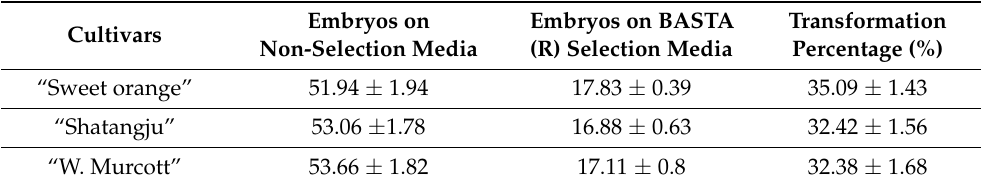
Figure 4. Embryonic callus induction, somatic embryo production, suspension cell culture estab- lishment and plant regeneration of the “Sweet orange” ( Citrus sinensis ) cultivar. ( Aa ) Embryonic callus induction from 8 weeks old ovule on EME medium ( Ab ) and somatic embryo development, ( B ) Suspension cell culture establishment in an H+H medium, ( C , D ) Callus formation and embryo ger- mination from suspension cell culture on an EME malt medium (the bars represent 0.5 mm), ( E ) Axis elongation of germinated embryos on an B+ medium, ( F ) Plants on RMAN rooting medium for root induction, ( G ) In vitro shoot grafted rootstock plant and ( H ) In vitro rooted plant transplanted on the soil. The bars represent 1 cm, except C and D. Table 1. Transformation percentage of embryos developed from the cell suspension. Results were expressed as mean ± standard error of three independent